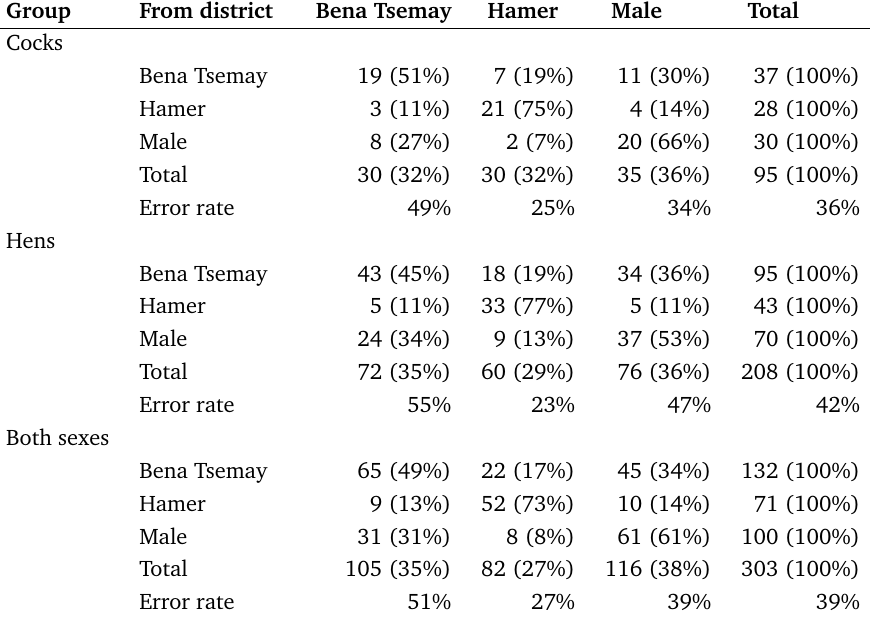
Table 10. Number and (percent) of observations classified into districts.